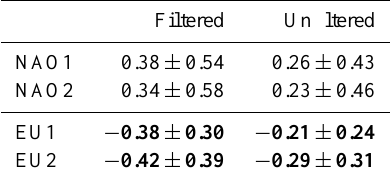
Table 1. Differences between solar maximum and minimum com- posites for various atmospheric indices in JFM over the period 1749–1990, together with their 99% confidence intervals. Values in bold are significantly different from zero at 5% level after a two- sided Student’s t test for the differences (note that none of the in- dices is subject to a significant serial correlation when using JFM averages). Refer to the text for details about the filtering procedure. Filtered Unfiltered